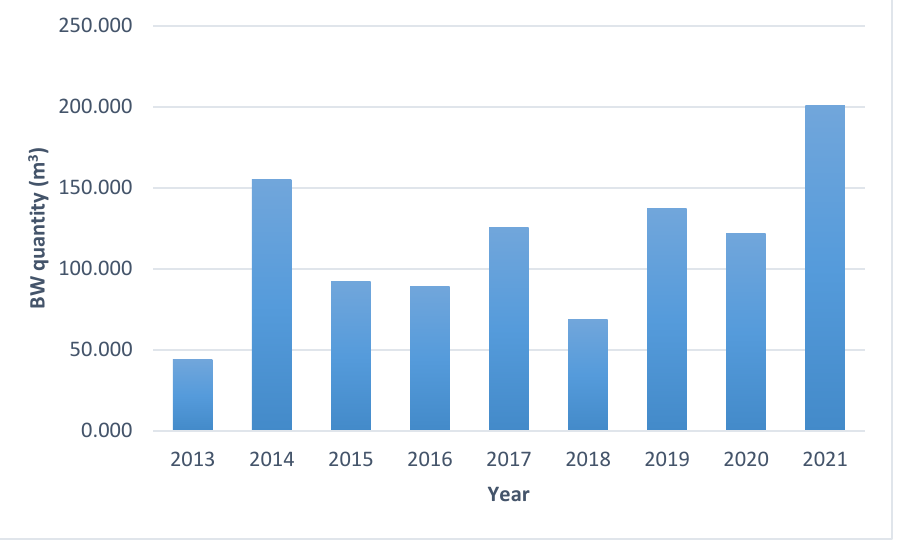
Figure 2. Annual quantities of BW discharged in the Port of Ploče.